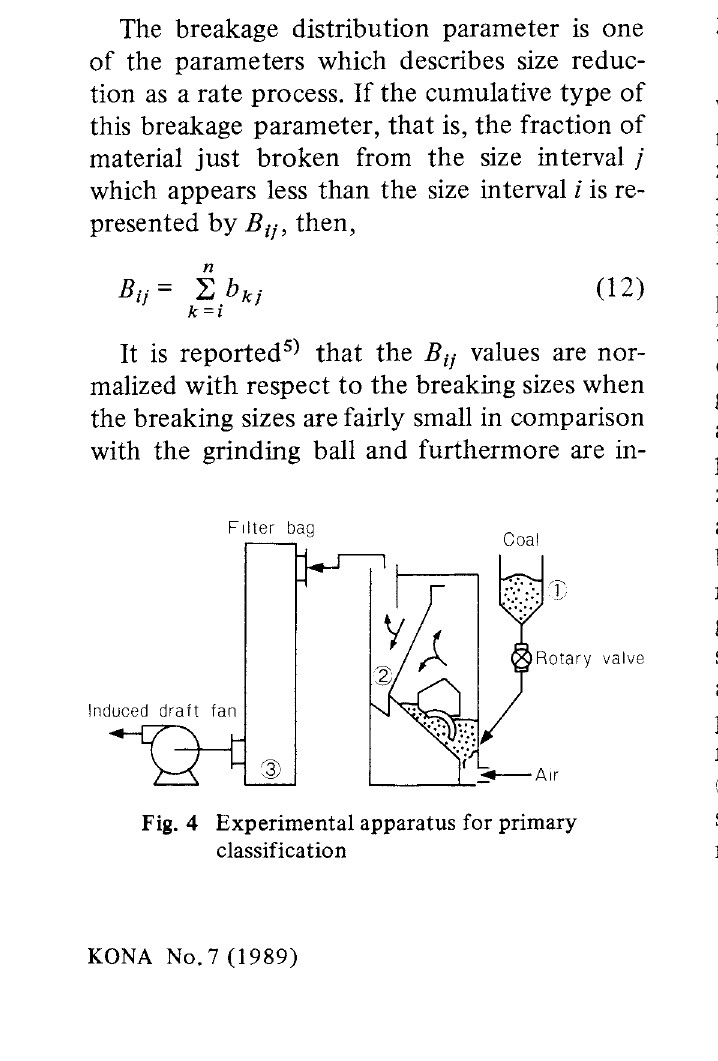
Fig. 4 Experimental apparatus for